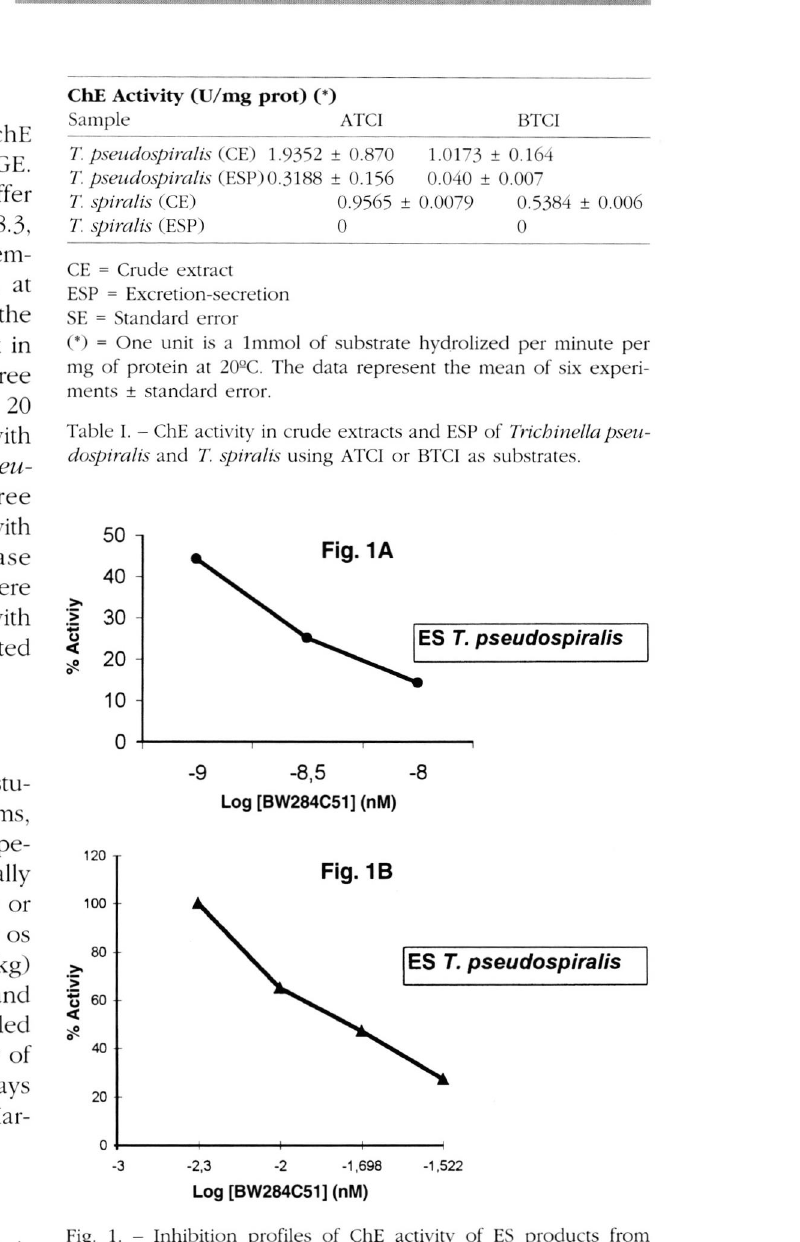
Fig. 1. - Inhibition profiles of ChE activity of ES products from T. pseudospiralis larvae by the AchE inhibitor BWC284C51 (nM) (A) and BchE inhibitor isoOMPA (B) (mM) when the substrate used was